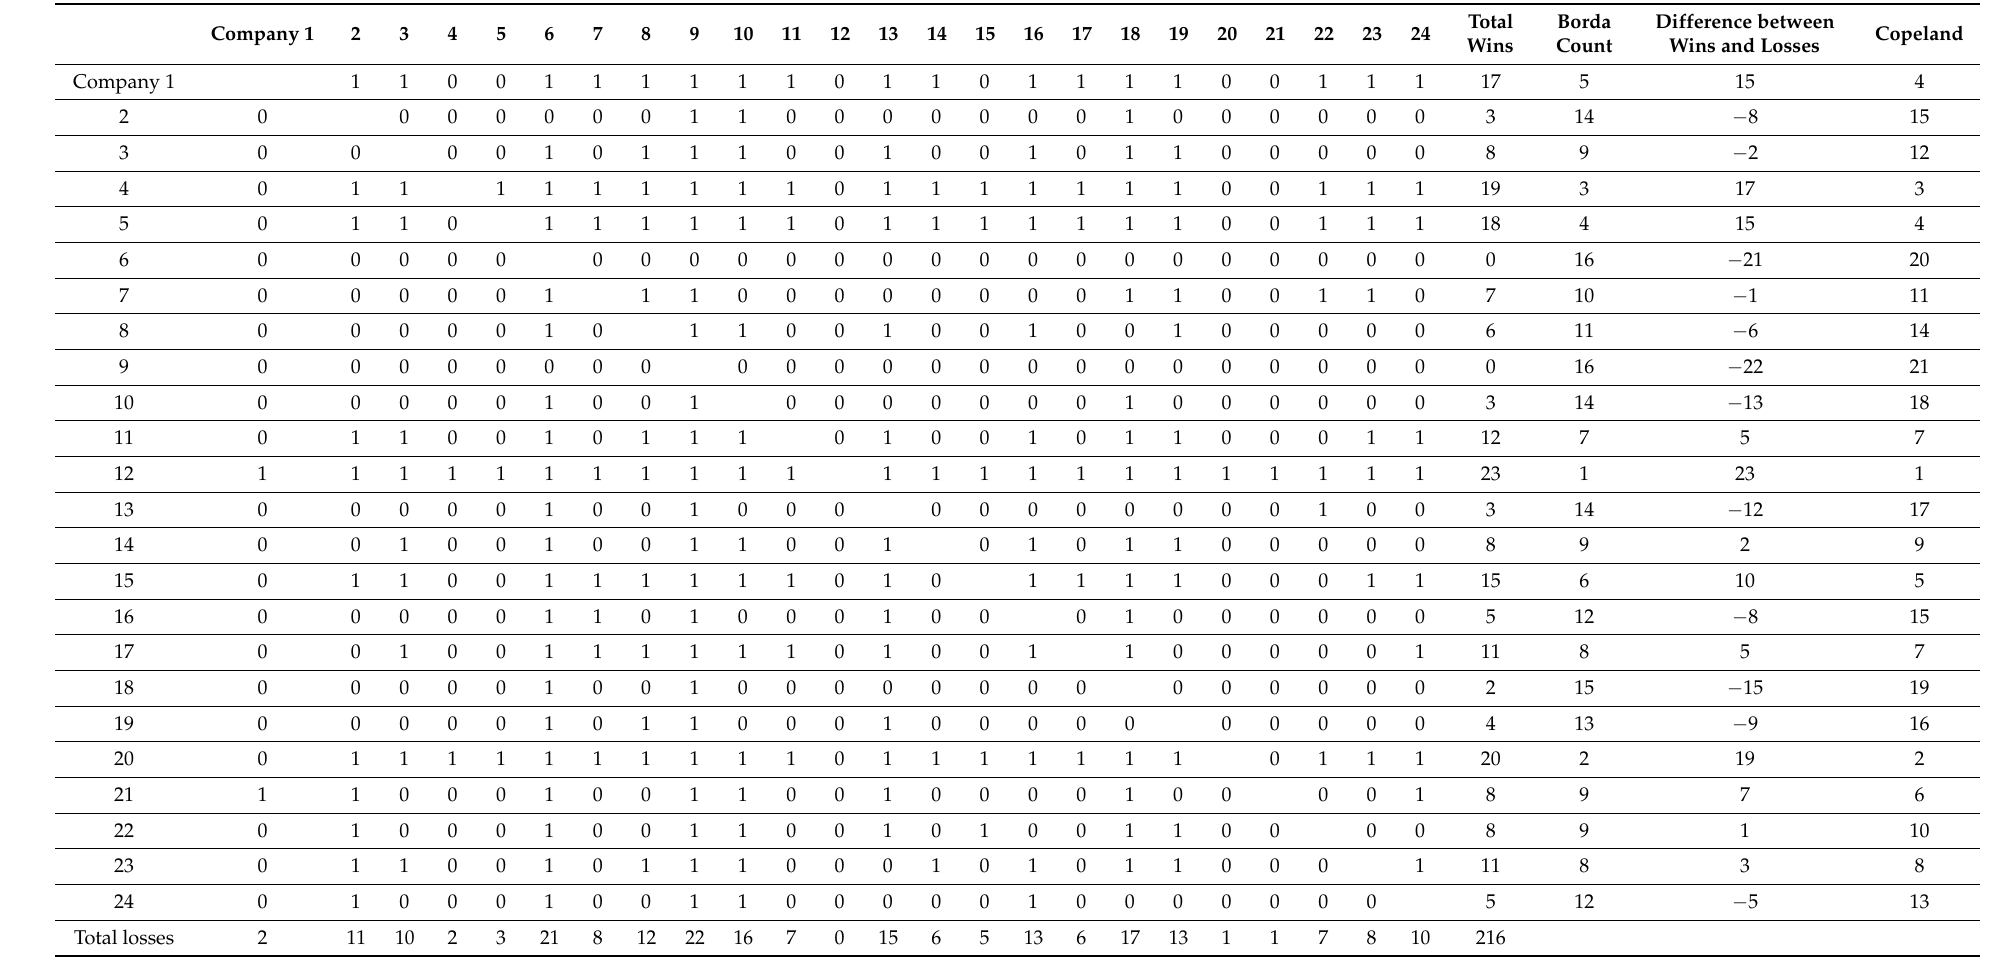
Table 4. Combined results according to Borda count and Copeland